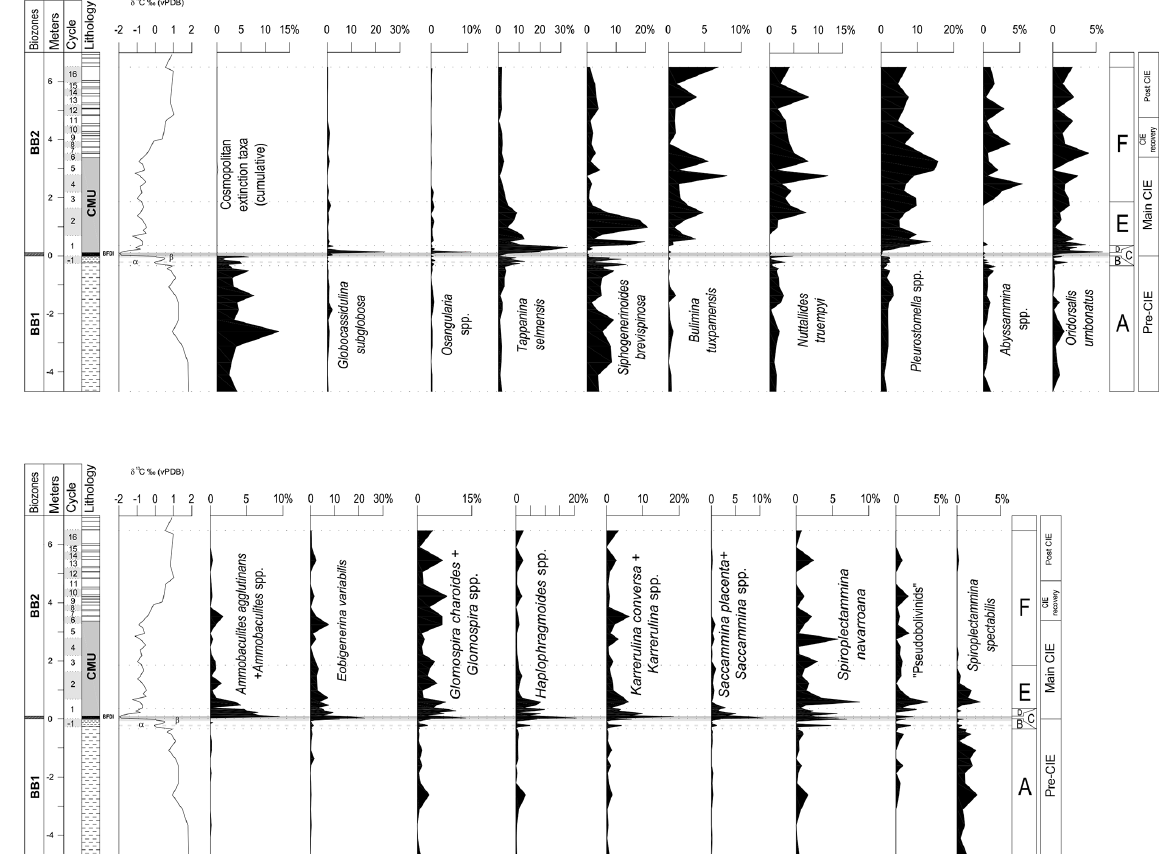
Figure 6. Relative abundance of selected benthic foraminifera across the PETM at Forada plotted against biostratigraphy, precessional cycles, lithology, δ 13 C bulk record, recognized benthic foraminiferal assemblages (A to F) and isotopic intervals. Benthic foraminiferal biozonation after Berggren and Miller (1989). The gray bands indicate intervals of carbonate dissolution. α : pre-CIE dissolution; β : burndown layer; BFDI: benthic foraminiferal dissolution